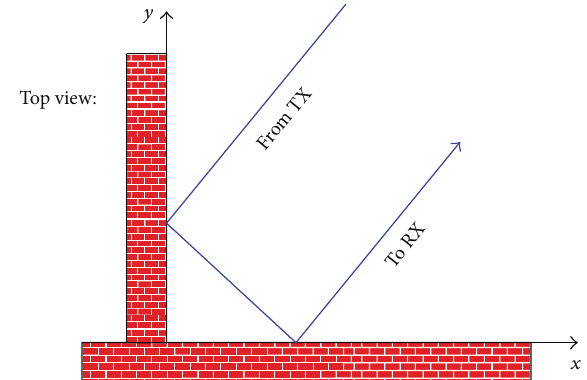
Figure 14: Corner reflection as it can be often found in urban